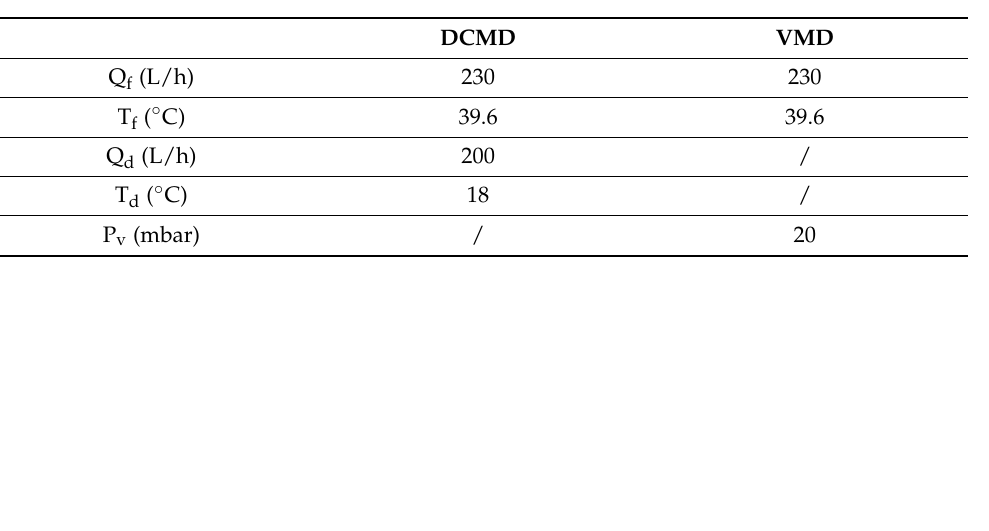
Table 2. Main operating conditions used during DCMD and VMD